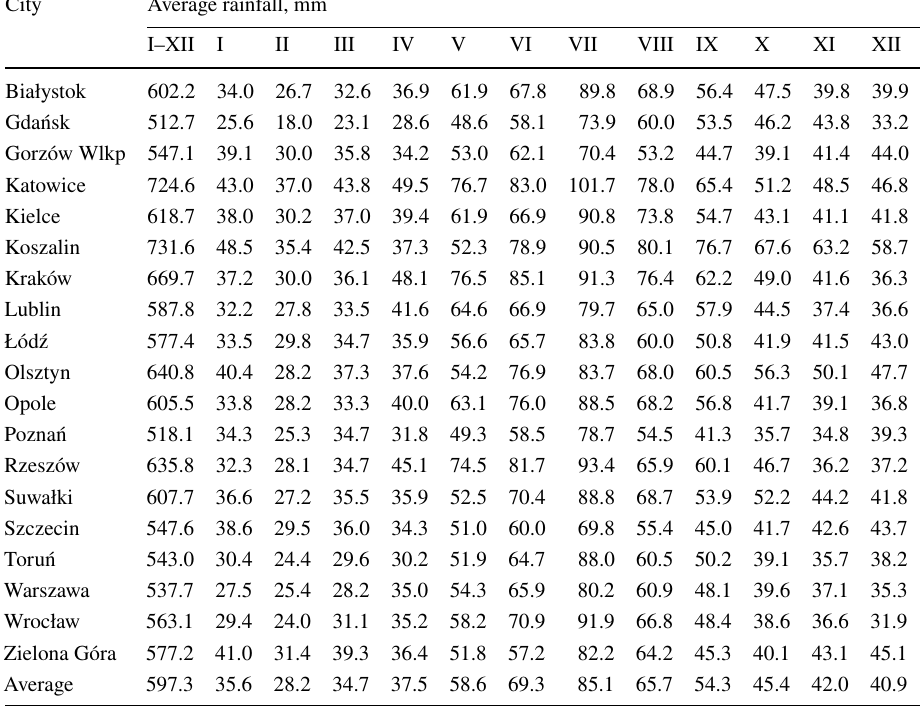
Table 1 Average annual and average monthly rainfall amounts in analysed